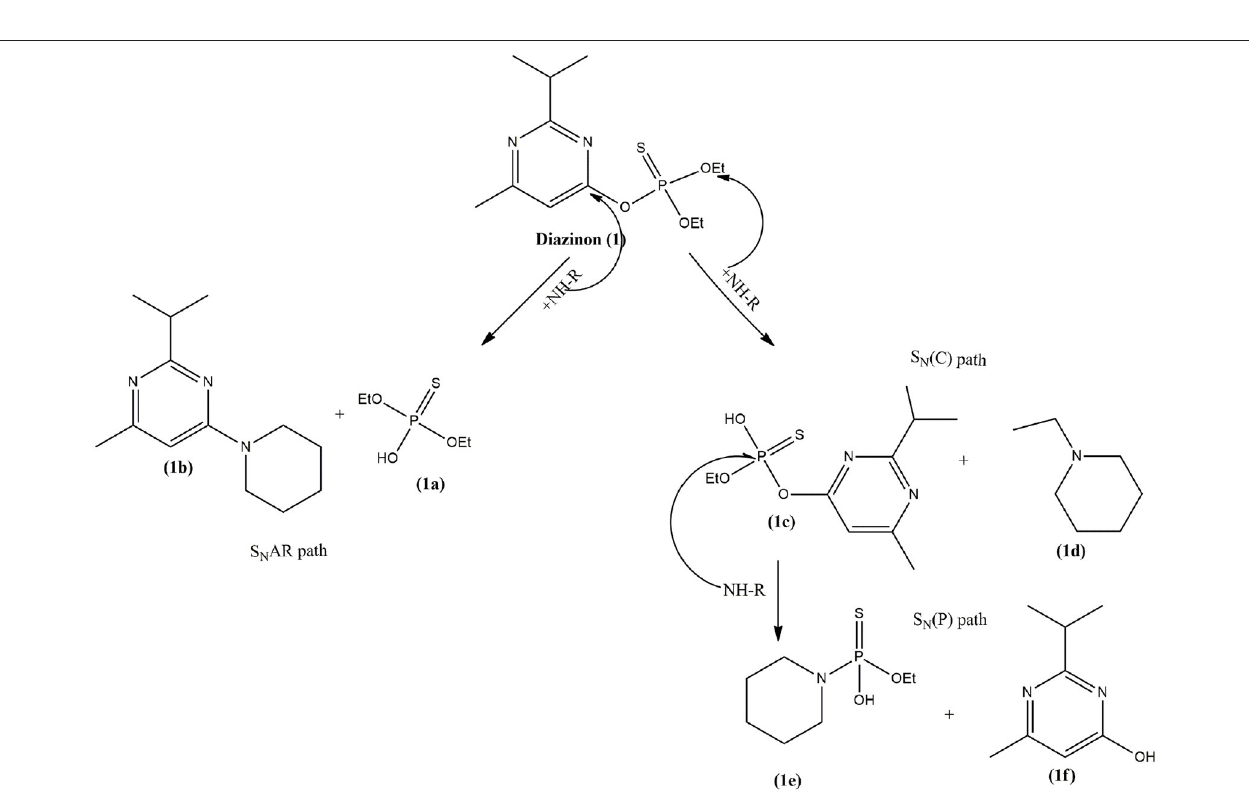
Frontiers in Chemistry |